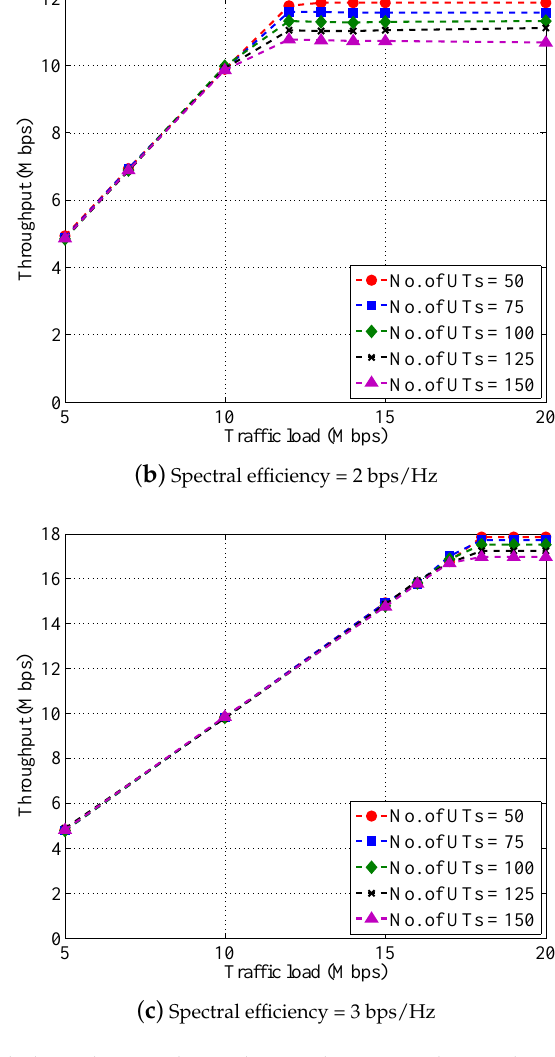
Figure 12. The network throughput at the application layer according to the traffic load (Mbps) when the number of UTs varies from 50–150 (VBDC).